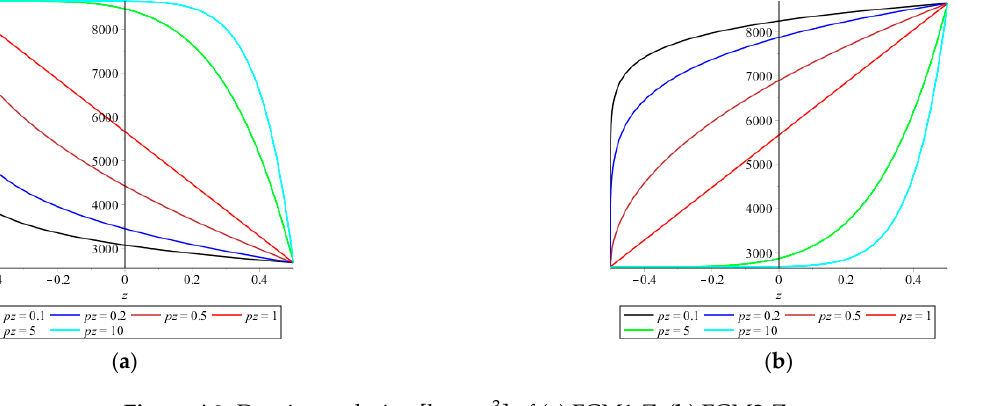
Figure A2. Density evolution [kg.m − 3 ] of ( a ) FGM1-Z; ( b ) FGM2-Z. The symmetrical mixture evolution along the beam length as jointly defined by Equations (2)–(4), is depicted for the Young’s modulus distribution in Figure A3 and for the density in Figure A4.